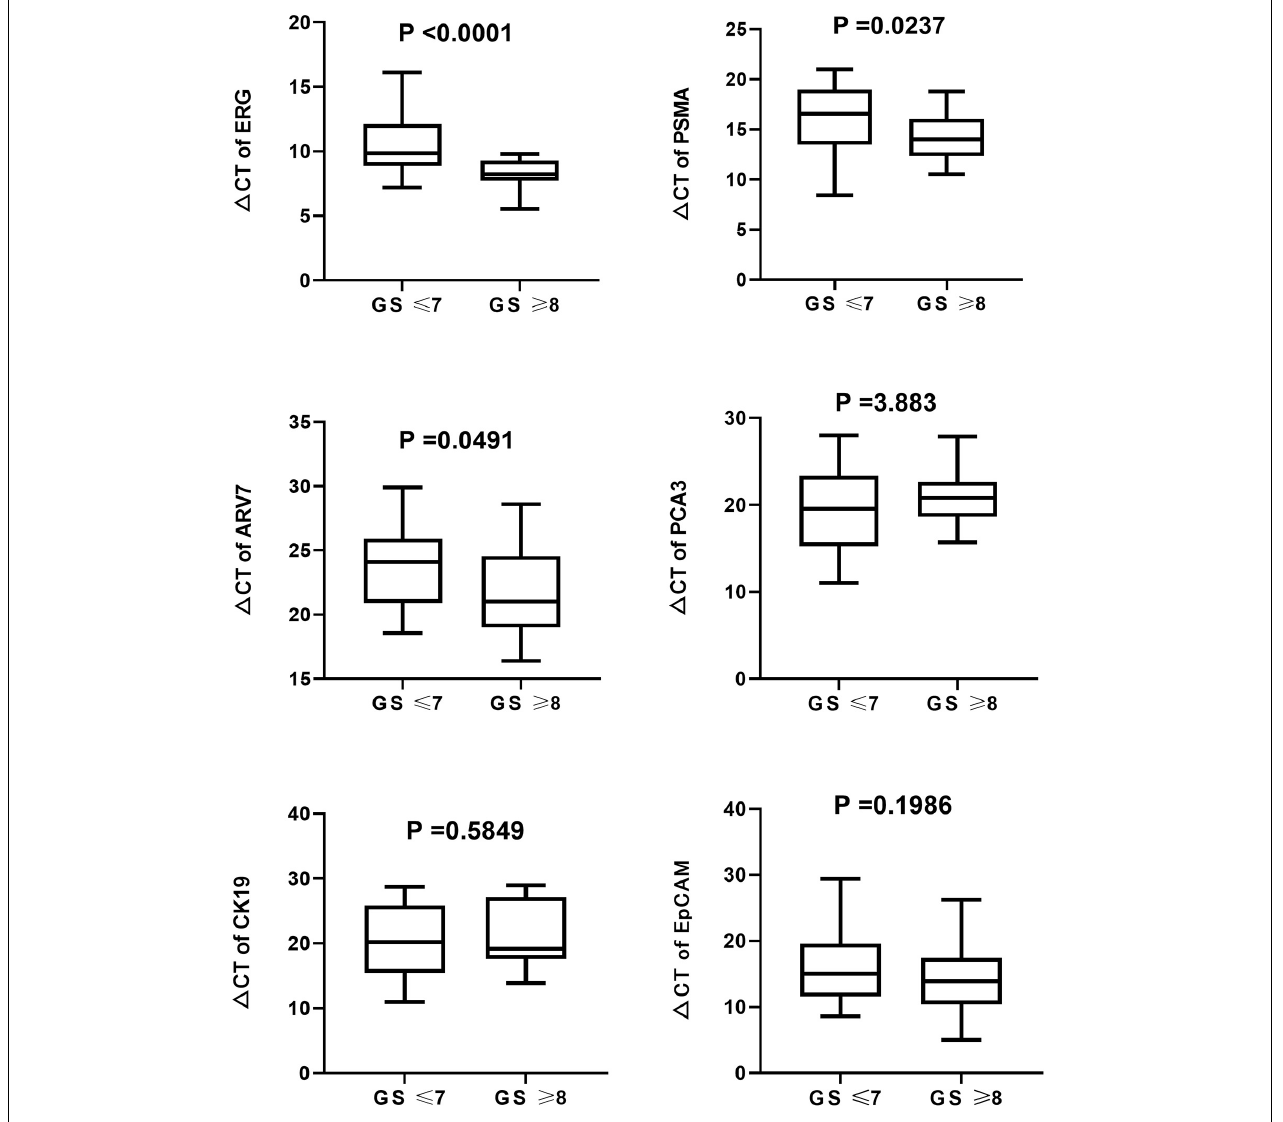
FIGURE 5 | Boxplots of the six mRNAs between PCa patients ( n = 63) and healthy subjects groups ( n = 61) in urinary exosomes. Statistical test: U